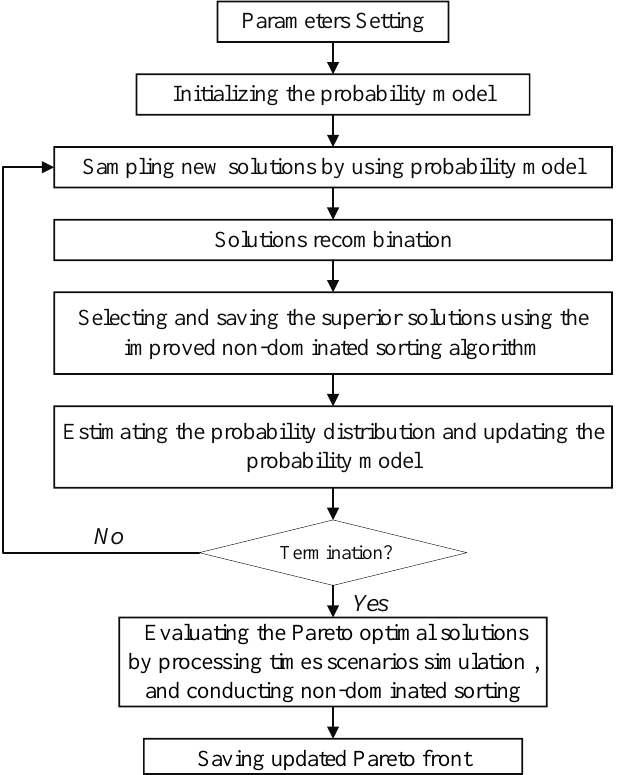
Figure 3. The framework of the MO-HEDA.